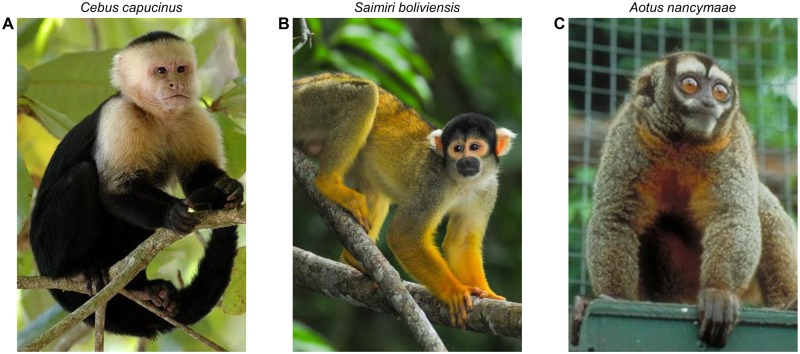
—Photographs representative of the NWM used in this study. (A) Cebus capucinus or capuchin monkey, (B) Saimiri boliviensis or squirrel monkey, and (C) Aotus nancymaae or owl monkey (Cawthon Lang 2005).